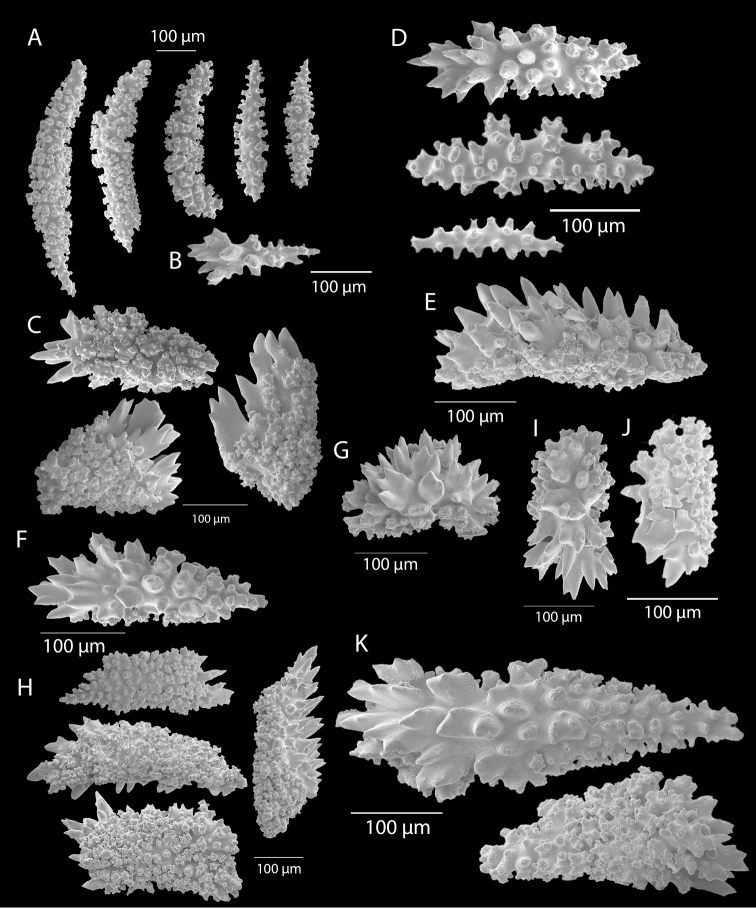
Muriceaplantaginea (= Muriceaappressa), SBMNH 422909 (Ecuador) and SBMNH 422417 (Baja CA Sur). Image included for comparison between sclerites found in M.californica and those seen in M.plataginea [= M.appressa Breedy & Guzmán, 2016]. SEM image. A–FSBMNH 422909 (A–C); E–F Calycular/coenenchymal sclerites A Elongated, jagged spindles B Small torch-type C Rounded, stout torches D Shorter, jagged spindles (axial sheath) E Unilateral spinous spindle F A second unilateral spinous form tending to torch shape G–KSBMNH 422417 Calycular and coenenchymal sclerites G Fan-shaped sclerite H Large, truncated unilateral spinous spindles I Stout prickly spindle J Rounded, unilateral spinous type K Torch-types typical of M.californica. Compare sclerites A–F with those shown in Breedy and Guzmán 2016 (fig. 15, for M.plantaginea) and sclerites G–K with those shown in Breedy and Guzmán 2016 (fig. 21, for M.californica).